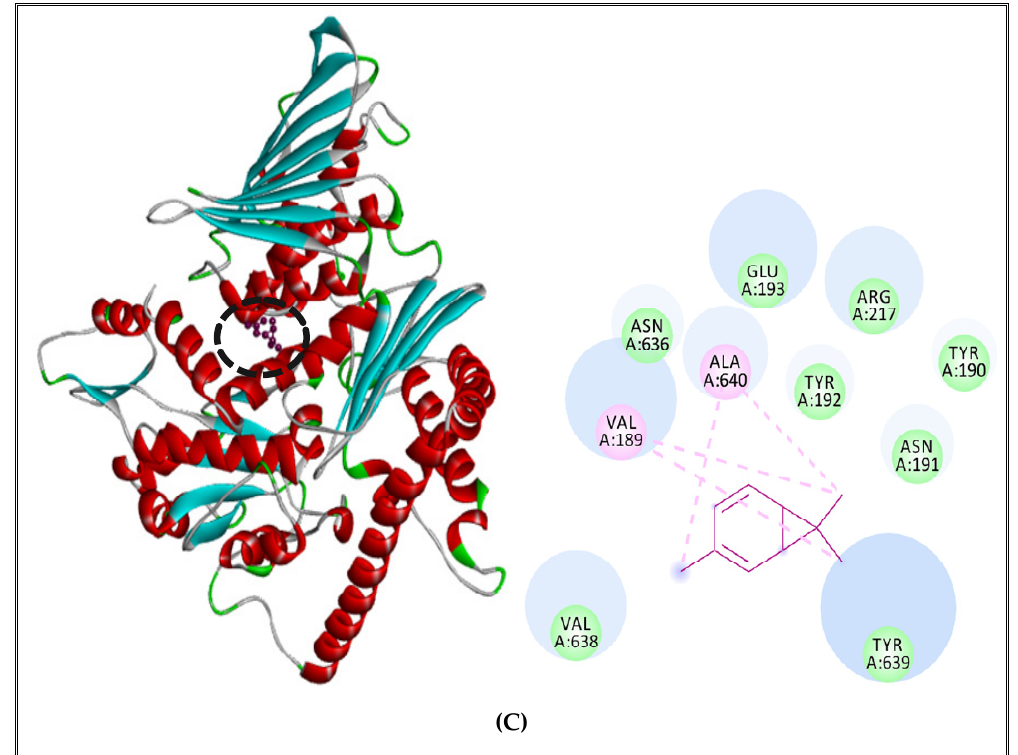
Figure 6. δ -3-Carene complexed with DNA polymerase enzyme ( A ), RNA polymerase ( B ), topoisomerase II ( C ) of S. aureus.